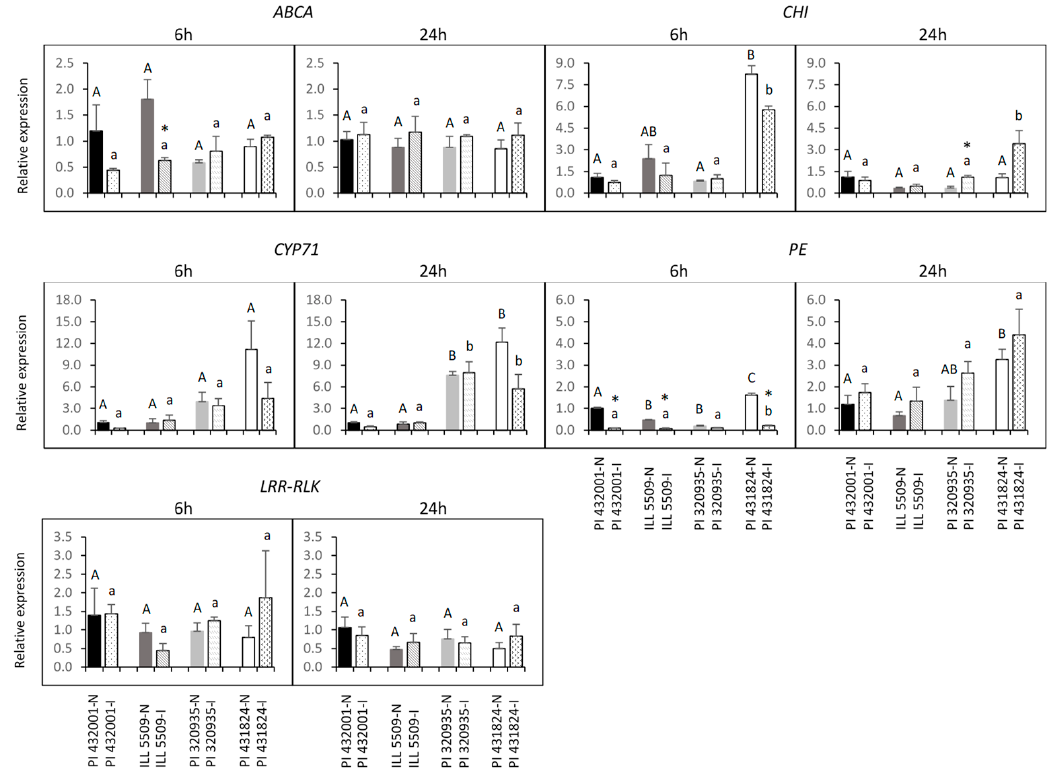
Figure 5. Expression profiles of putative genes. Relative expression levels were normalized by ß-tubulin-3. Four accessions (two partially resistant accessions: PI 432001 and ILL 5509; two susceptible accessions: PI 320935 and PI 431824) were analyzed in non-inoculated (N) and inoculated (I) with A. euteiches conditions at two time-points (6 and 24 hours post inoculation: 6 hpi and 24 hpi). Error bars represent standard error of the mean. Asterisks indicate statistically significant di ff erences ( p < 0.05) between inoculated plants and non-inoculated plants. Capital letters represent significant di ff erences among all four accessions under the non-inoculated condition, while lowercase letters indicate significant di ff erences among all four accessions under the inoculated condition. Abbreviations: ABCA gene encoding ABC transporter A family protein (ABCA), CYP71 gene encoding Cytochrome P450 family 71 protein (CYP71), LRR-RLK gene encoding LRR receptor-like kinase (LRR-RLK), CHI gene encoding Chalcone-flavanone isomerase family protein (CHI), and PE gene encoding Pectin esterase (PE)